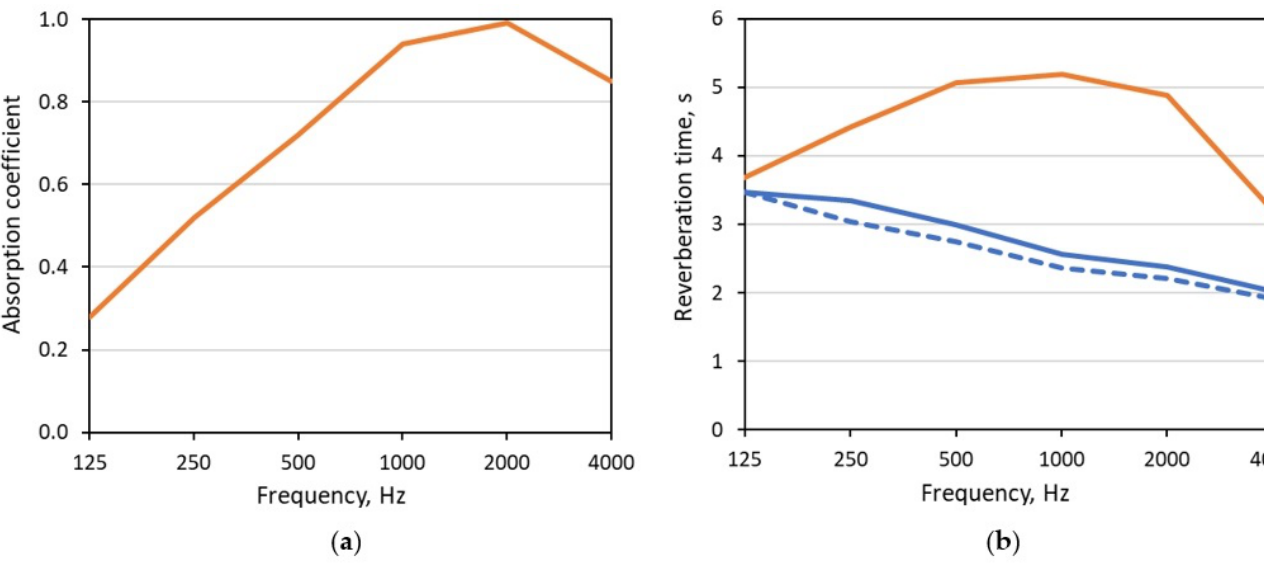
Figure 7. Absorption coefficient ( a ) of a porous coating on the ceiling in the food court FC1 and reverberation time ( b ) measured before (red) and after (blue) reconstruction in comparison with the expected one (blue, dotted).